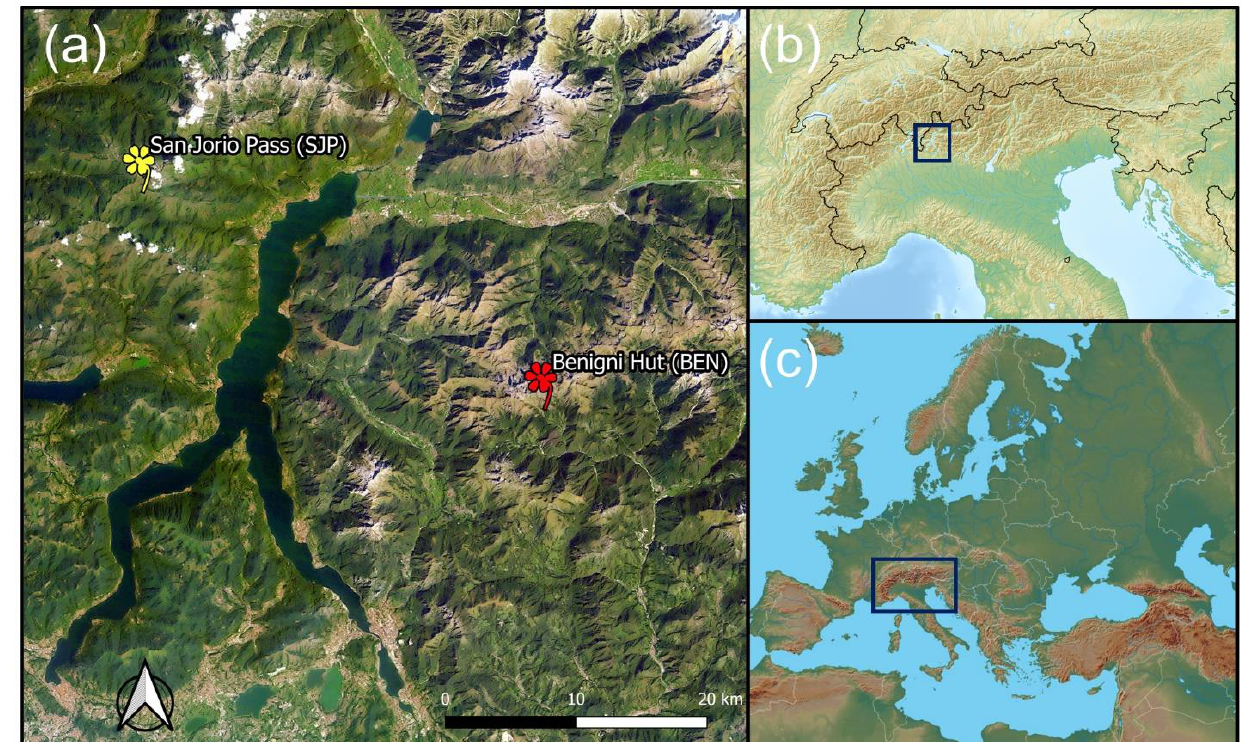
Figure 2. Study sites ( a ) and their location in the Alps ( b ) and in Europe ( c ). At the first site (SJP), the fieldwork was conducted on an A. brevis population located along the ridgeline north of the San Jorio Pass and southwest of Cugn Peak (UTM WGS84 — 32T E 512338 N 5112905, 2193 m asl), close to the Mountain Huts ‘ Rifugio San